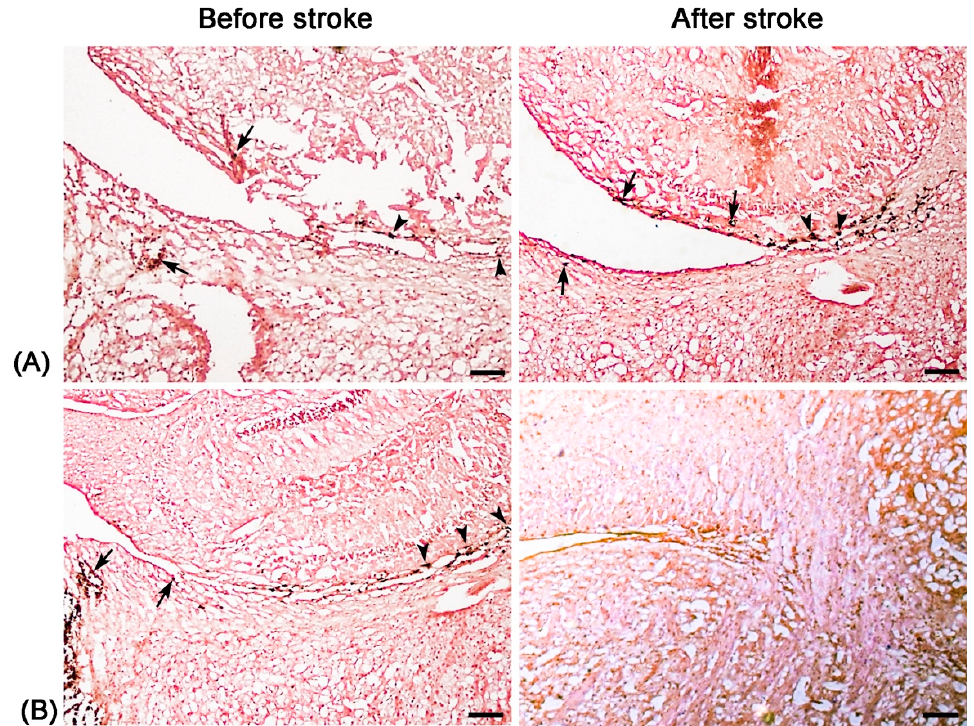
Figure 4. Histologic assessment of the distribution of molecular probes. Representative micrographs show that after intraventricular injection of anti-CD15-SPIONs, DAB-enhanced Prussian blue staining reveals that positively stained anti-CD15-SPIONs (dark brown) are localized around cells and extracellular matrix within SVZ (arrows) and RMS (arrowheads) before stroke in the pure stroke mouse ( A ) and the stroke mice with Ara-C treatment ( B ); Eight days after stroke, the number of positive particles in the pure stroke mouse increases obviously ( A ) but remarkable decrease is found in the stroke mouse after administration of Ara-C ( B ). Bars = 50 μ m.